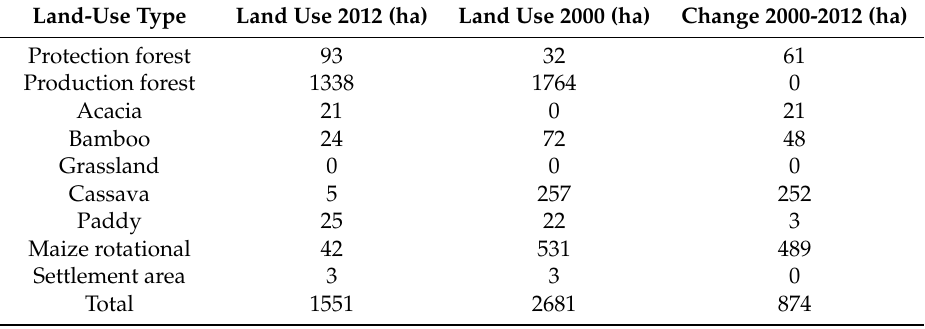
Table A2. Village area of the different land-use types; based on participatory mapping on 3D maps. Land-Use